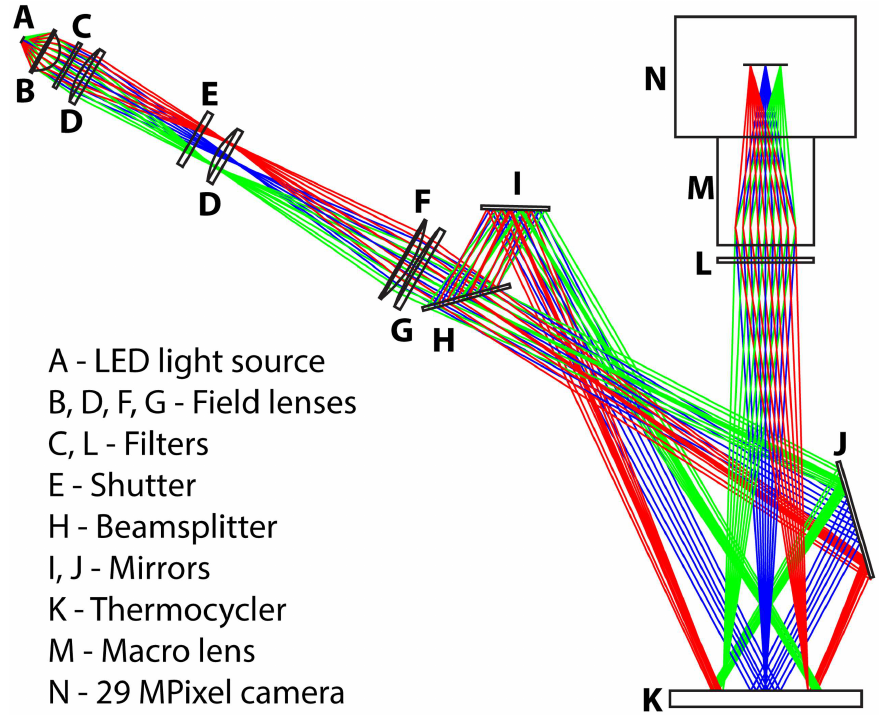
Fig 3. A schematic showing a scale representation of the physical layout of the custom real-time digital nucleic acid amplification instrument. Colored lines indicate ray paths.